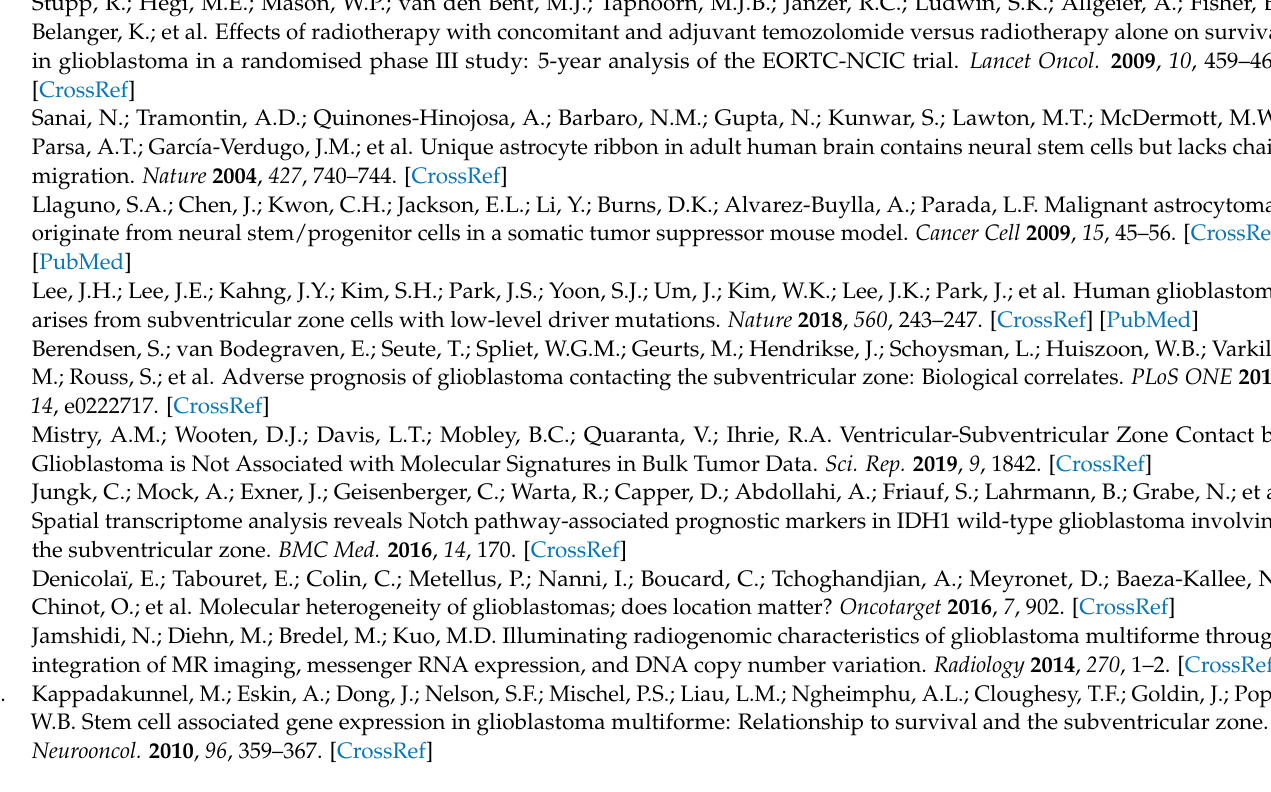
entially expressed genes, withinSVZ samples vs. outsideSVZ samples, Figure S3: DCAF4 expression plot, Figure S4: Top 50 most differentially expressed genes, withinSVZ samples vs. noSVZcontact samples, Figure S5: Top 50 most differentially expressed genes, outsideSVZ samples vs. noSVZcontact samples, Table S1: Verhaak subtype(s) in SVZ-contacting glioblastomas and glioblastomas without SVZ contact, Table S2: Hallmark genesets in within SVZ-contacting glioblastoma ( withinSVZ -samples vs. outsideSVZ -samples) analysis with FDR < 0.25 sorted by p -value. Table S3: Hallmark genesets in withinSVZ -samples vs. noSVZcontact -samples analysis with FDR < 0.25 sorted by p